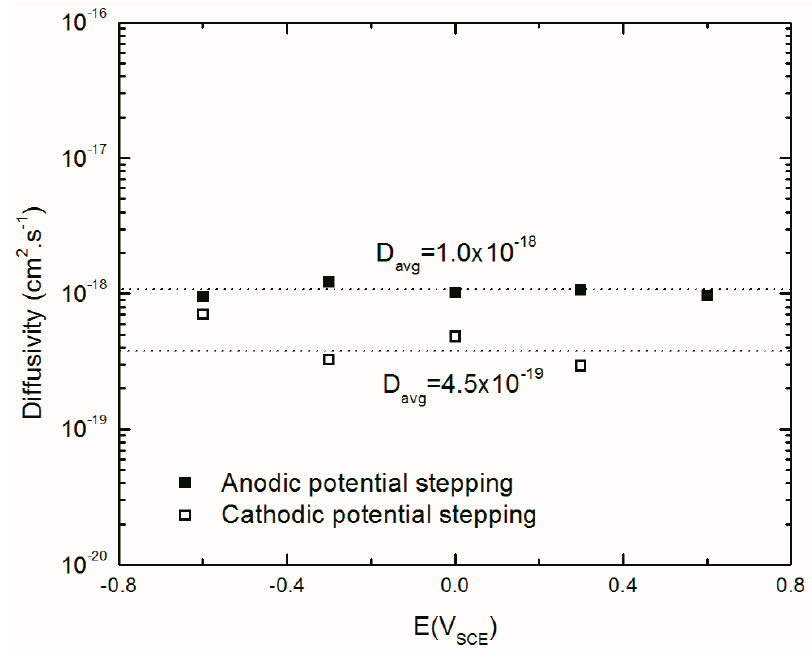
Figure 14. Calculated di ff usivity of Al ion interstitials in the barrier layer with optimization of the EIS results at di ff erent potentials during anodic and cathodic potential